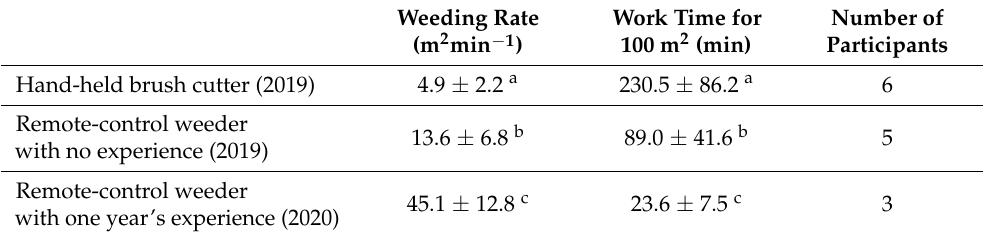
Table 1. Work time and weeding rate in the weeding experiment.